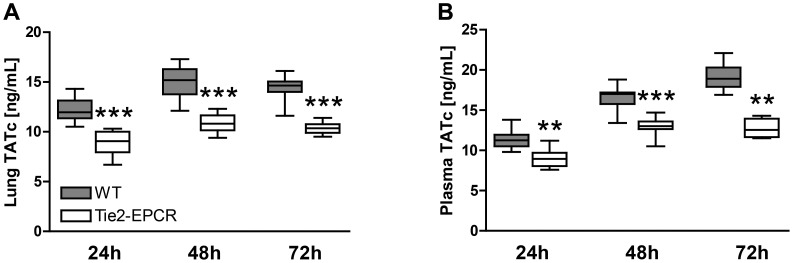
Tie2-EPCR mice show increased activation of coagulation both in lung homogenates and plasma.Mice were infected intranasally with 300 CFU of B. pseudomallei. After 24, 48 and 72 hours coagulation activation (TATc) was measured in lung homogenates (A) and plasma (B). At all time points decreased activation of coagulation was seen in Tie2-EPCR mice when compared to WT mice. Data are expressed as box and whisker plots showing the smallest observation, lower quartile, median, upper quartile and largest observation. Grey boxes represent WT mice, white boxes represent Tie2-EPCR mice (n = 8–9 mice per group for each time point). **P<0.01 and ***P<0.001 for WT versus Tie2-EPCR mice (Mann-Whitney U test).